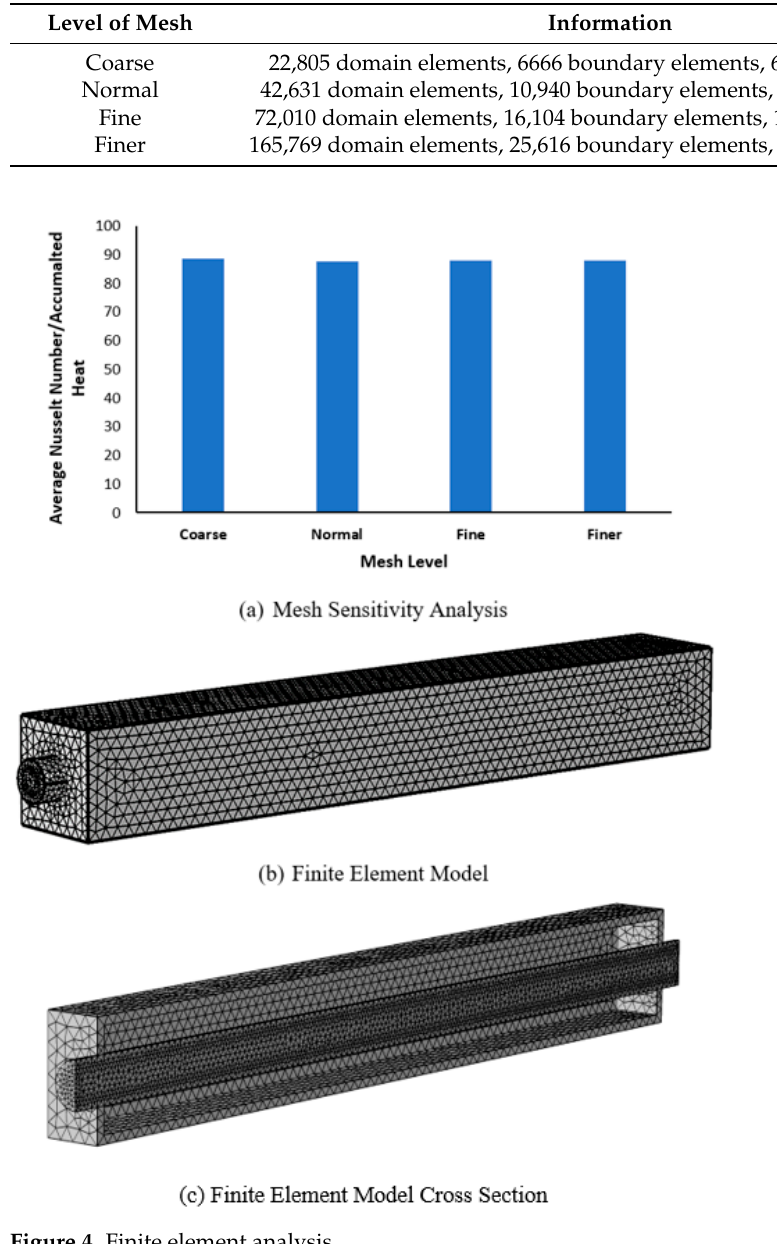
Figure 4. Finite element analysis.